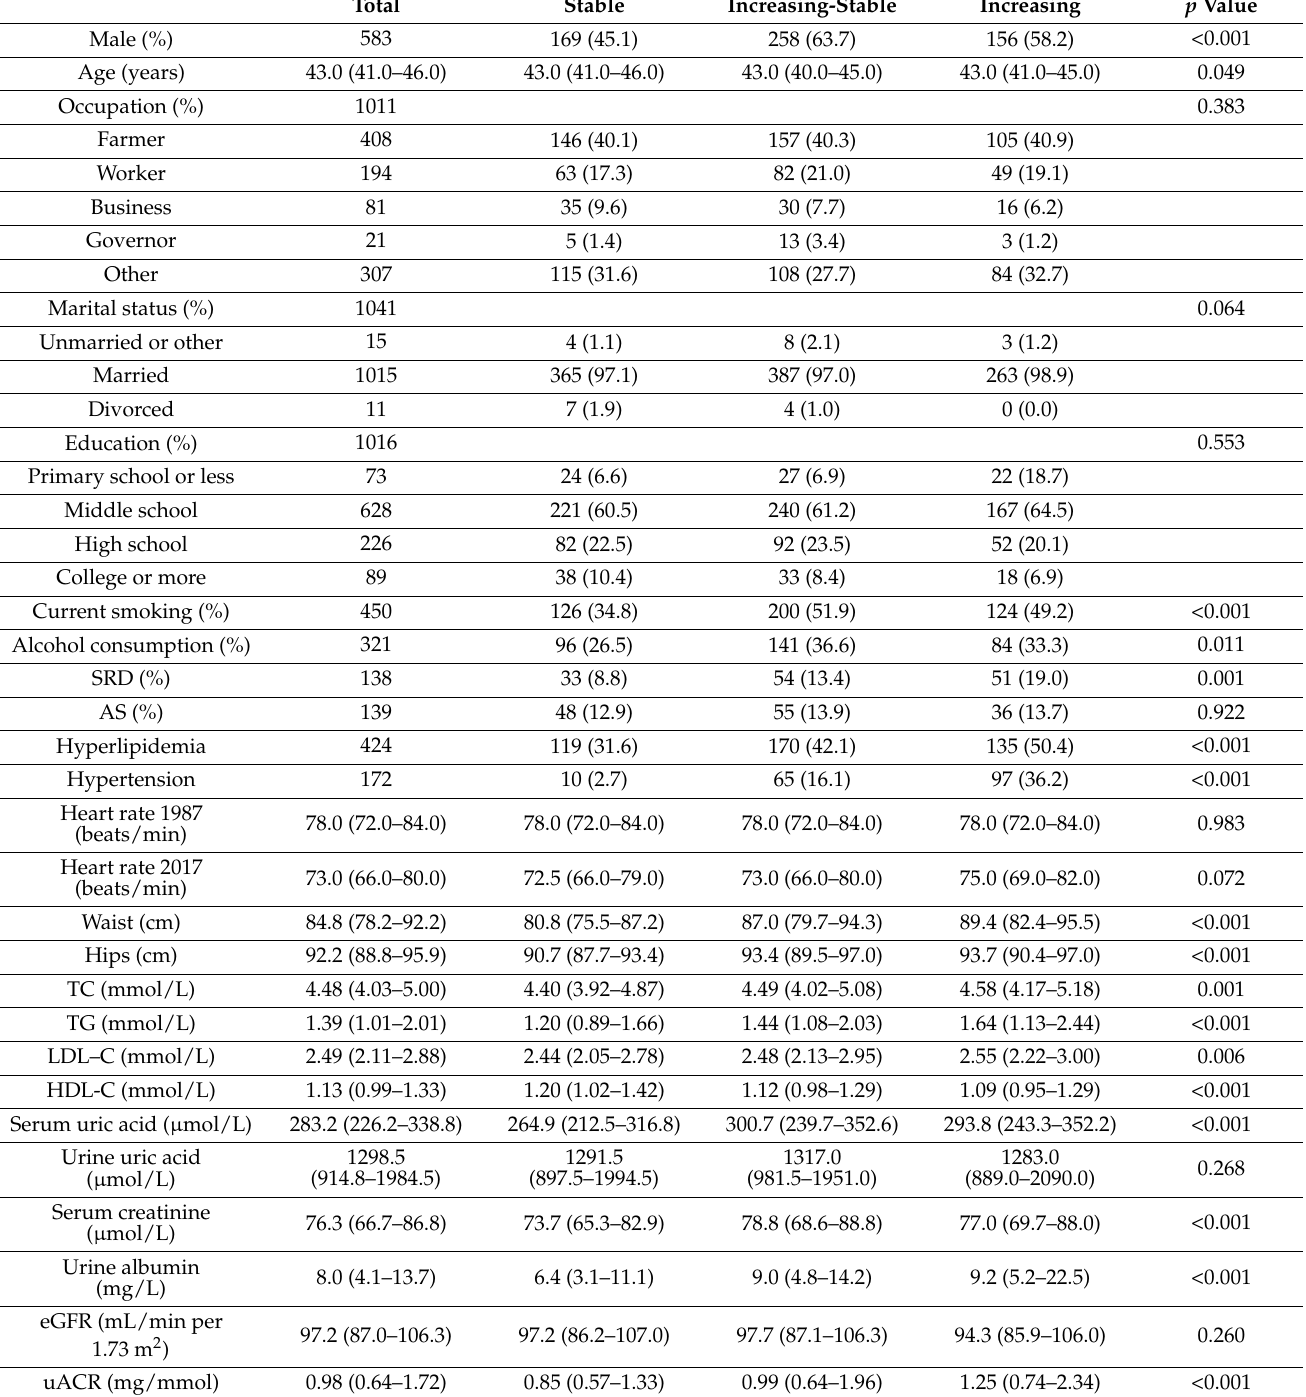
Table 2. Demographic characteristics and cardiovascular risk factors by the SRD risk score trajec- tory groups.